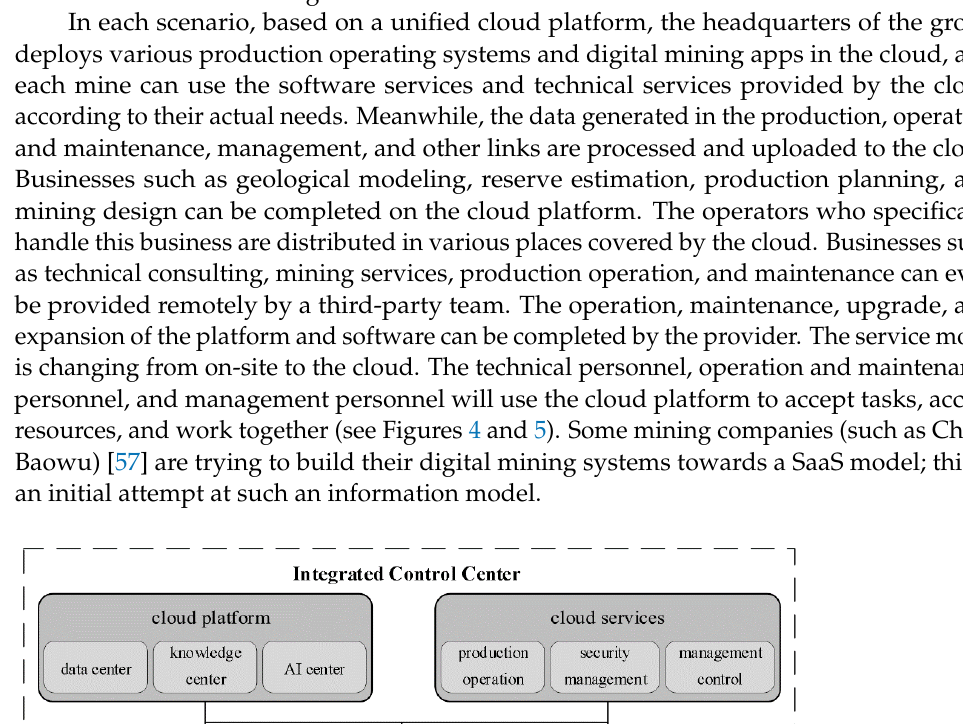
Figure 5. A mine production and operation management scenario under CM mode. 5.2. Realization Stages Intelligent construction and changes in the new mode will not happen overnight. Intelligent equipment and digital systems can only be improved through application and upgrading [58]. The realization of the CM mode is also a gradual process, which can be divided into three stages: The first stage is achieving the production and management intelligence of the mine. It is necessary to rationally adjust the stope structure and process to enable the unmanned operation of the entire mining operation process, and to use the sensor net- work to effectively obtain the data. Then, by establishing a production management and control platform, it is possible to integrate the management of production equipment, business systems, software, and hardware. Finally, by using data analysis, we can achieve intelligent mine production and management. The second stage is achieving the cloud collaboration of mining groups and indus- trial clusters. By building a digital collaboration platform within the group to achieve the integration and optimization of the whole process elements, the upstream and down- stream industry clusters establish a cloud cooperation platform together. The service mode will be changed from “on-site mode” to “cloud mode”, enabling data connection and cloud collaboration.